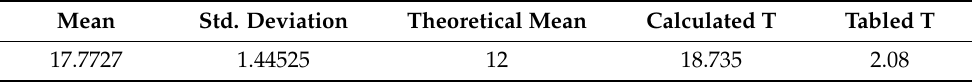
Table 8. The complete statistical analysis of the Satisfaction parameter.